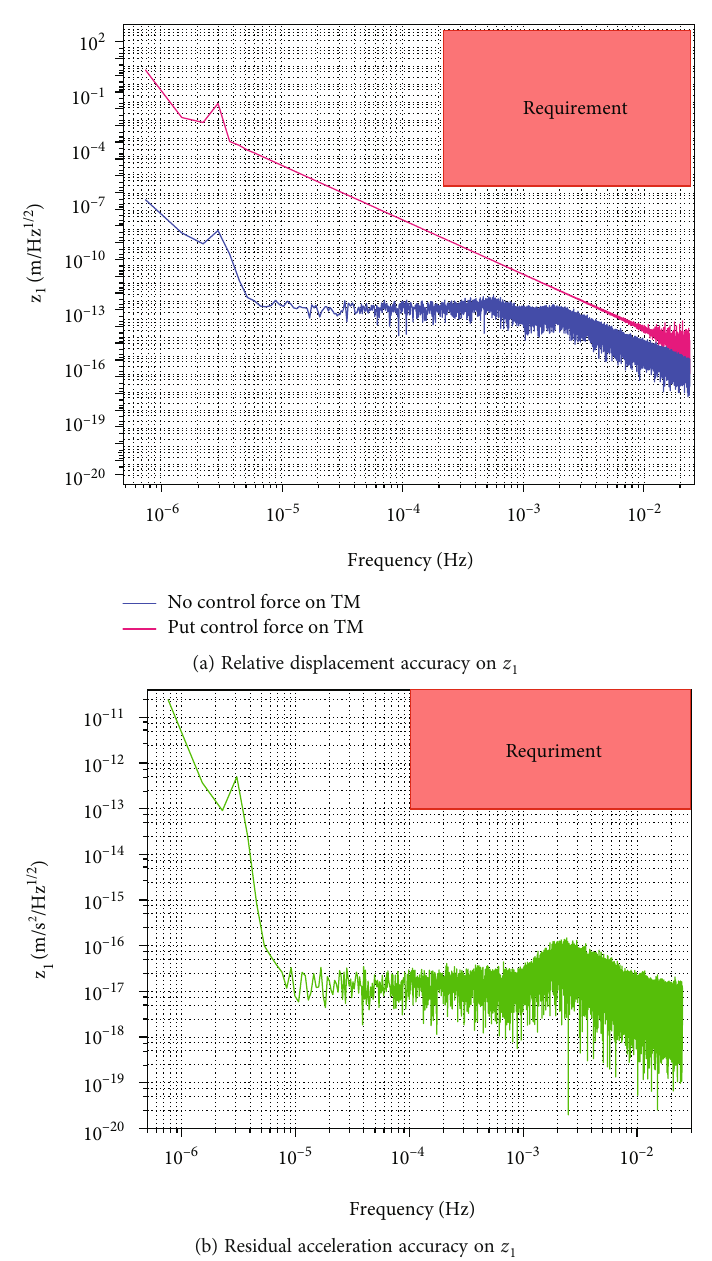
Figure 11: The displacement accuracy and residual acceleration accuracy of the relative motion on z